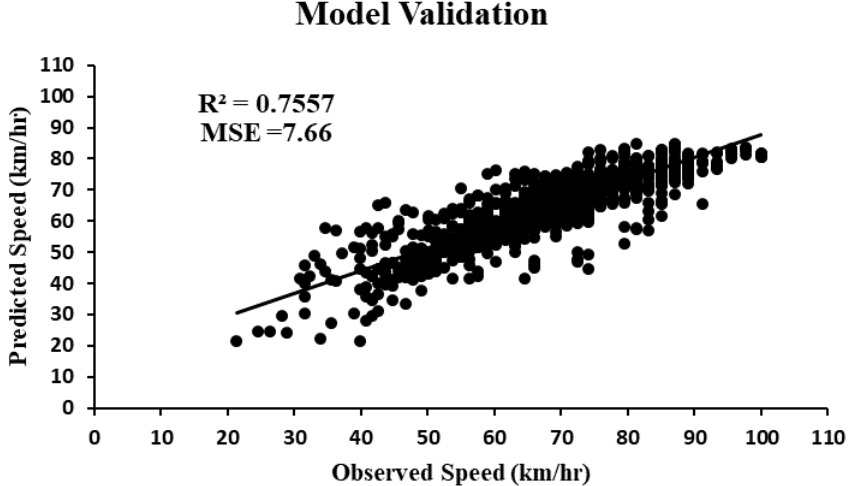
Figure 6. Observed vs. Predicted Plot for Developed Model.